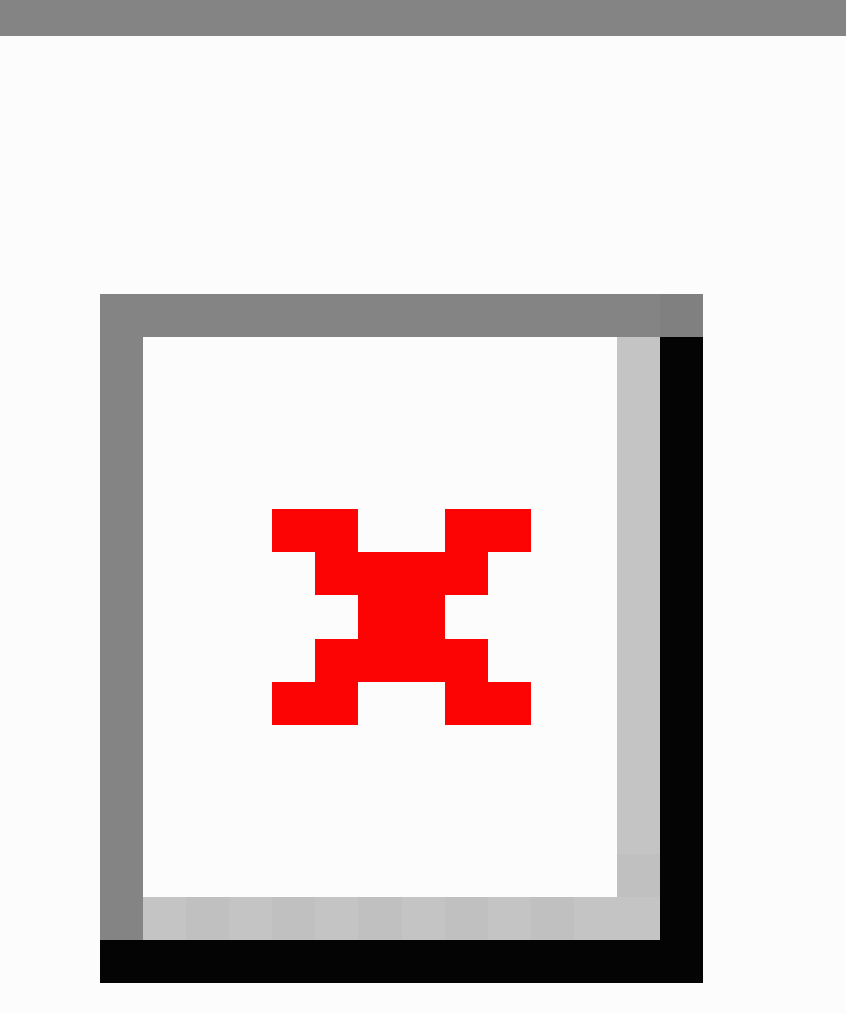
Figure 3. Percentage weight loss over 6 months for the unsuccessful (<5% weight loss), moderate success (5%-9.9% weight loss), and high success ( ≥ 10% weight loss) groups using KiloCoach. *= start of significant difference among the 3 subgroups (Kruskal-Wallis 1-way ANOVA, P